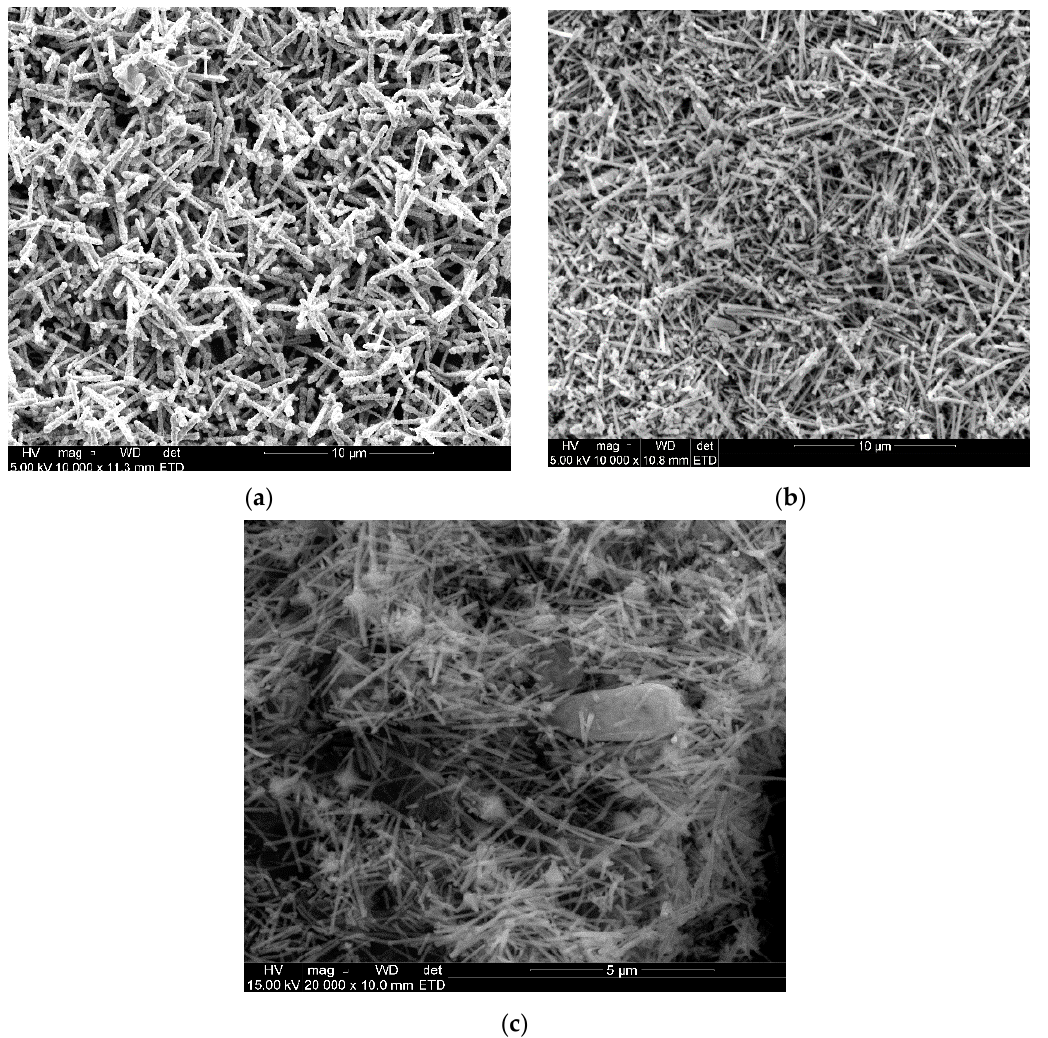
Figure 5. SEM images of CuONPs from citrus peel extracts using distilled water as a solvent. ( a ) Lemon, ( b ) tangerine and ( c ) orange.